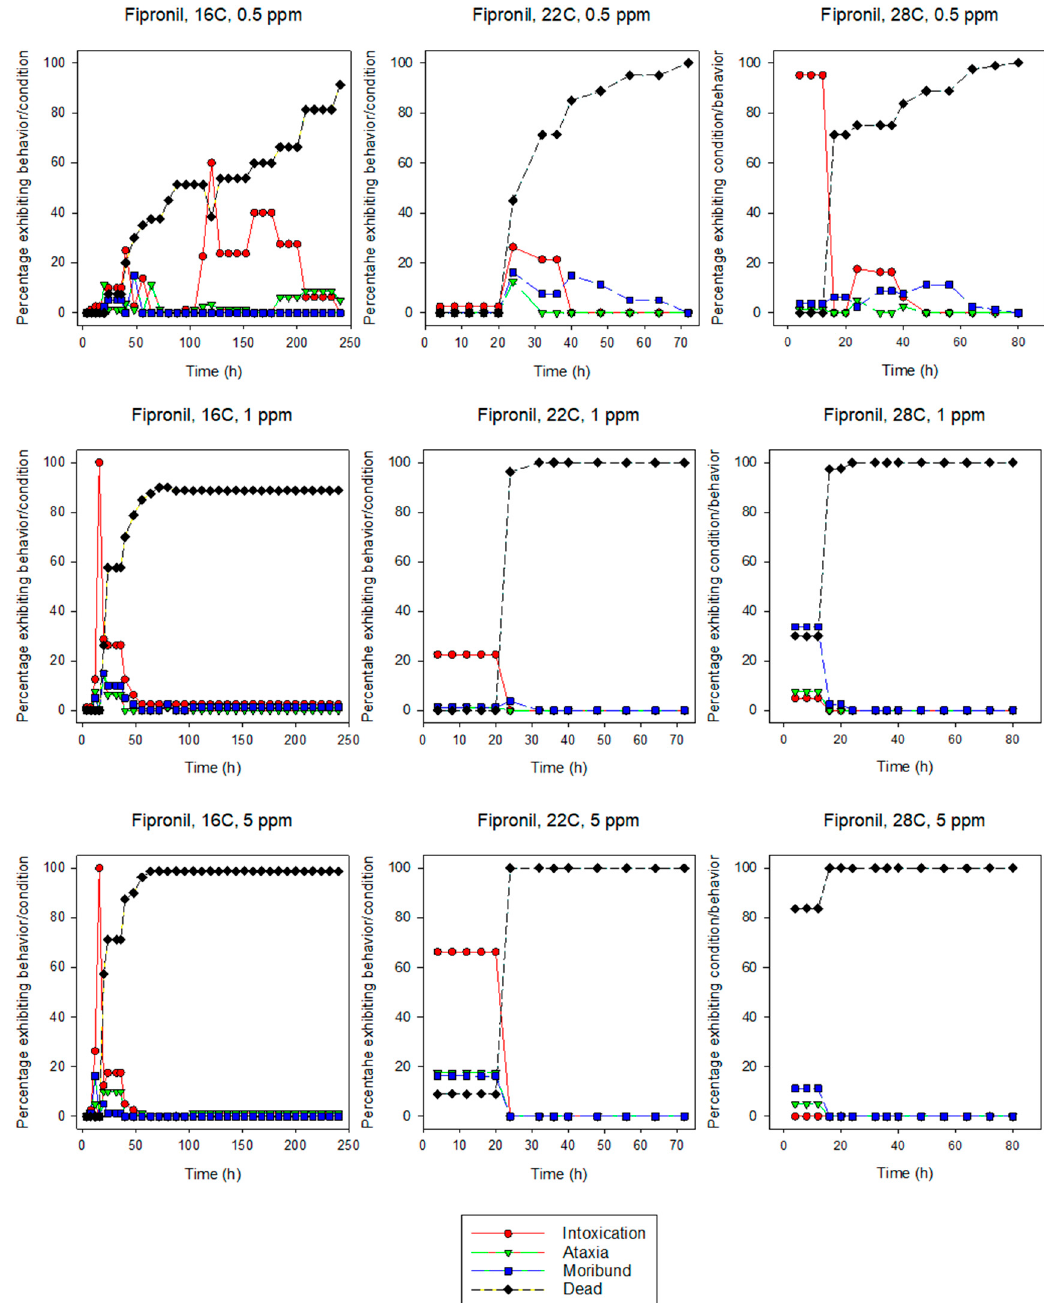
Figure 2. Effects of concentration and temperature on the behaviors of fipronil-exposed Formosan subterranean termites, C. formosanus .